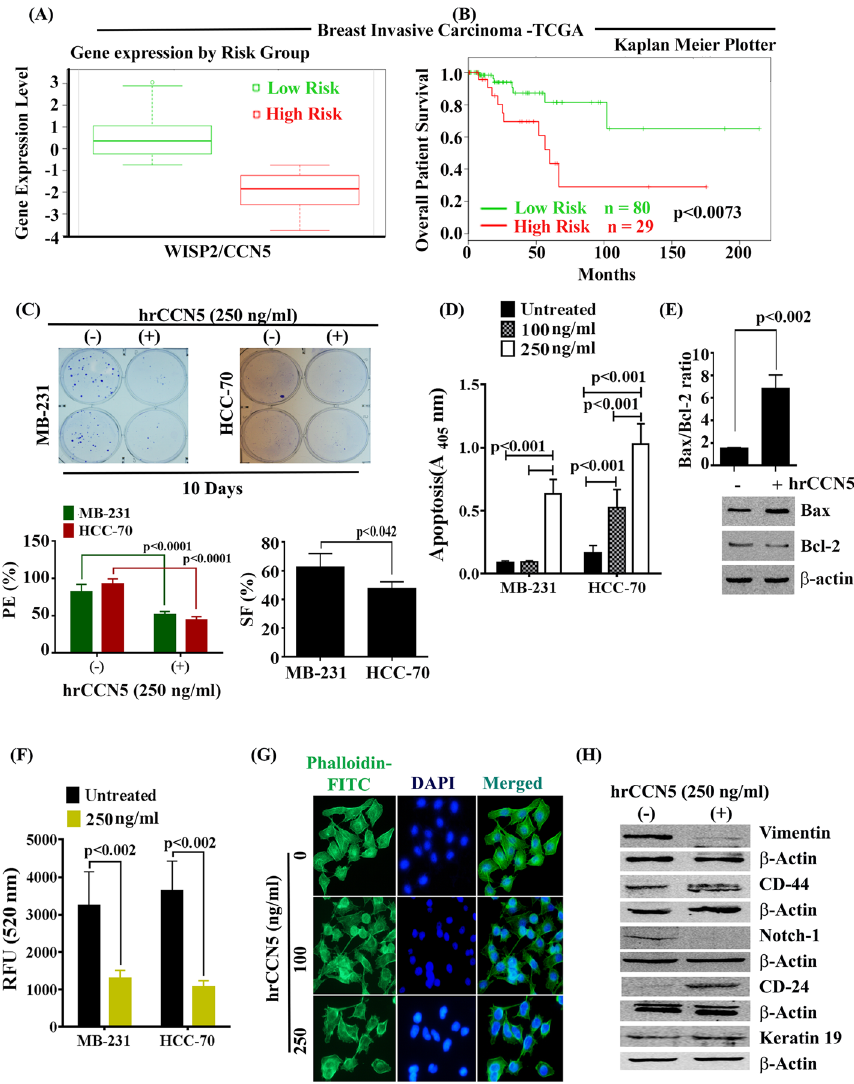
Figure 1. CCN5 overexpression is associated with good prognosis of human breast cancer and CCN5- treatment suppresses growth and invasive phenotypes of TNBC cells. ( A ) Plots generated by SurvExpress program to analyze samples of breast invasive carcinoma patients from TCGA show the expression levels of CCN5. Low- and high-risks groups are shown in green and red, respectively. ( B ) Kaplan-Meier overall survival curves of CCN5 signatures were constructed by using the SurvExpress program and the P-value resulting from a t-test of the difference. Low- and high-risks groups are shown in green and red, respectively. ( C ) Effect of hrCCN5 or vehicle alone (control) on cell survival of TNBC cells (i.e., MDA-MB-231 and HCC-70) was measured after 48 h using anchorage-dependent growth (ADG)/Colony/focus forming assay. We determined the plating efficiency (PE) (left panel) and survival fraction (SF) (right panel) in both cell lines as described in Materials and Methods. Upper panel is the representative images of ADG in different treatment setups. Bar graphs indicate PE (left) and SF (right) in hrCCN5-treated or control samples. Error bars indicate mean ± SD, and represent at least three independent experiments. ( D ) Dose-dependent effect of hrCCN5 on apoptotic cell death was measured in TNBC cells after 48 h using cell-death detection ELISA kits. Error bars indicate mean ± SD, and represent at least three independent experiments. ( E ) Representative Western blots and quantification (bargraph) of Bax/BCl-2 ratio in the lysates of hrCCN5-treated or vehicle-treated MDA-MB-231 cells. β -actin was used as loading controls. Error bars indicate mean ± SD, and represent at least three independent experiments. ( F ) Effect of hrCCN5 or vehicle alone on aggressive malignant phenotypes of TNBC cells was measured by anchorage-independent growth (AIG) using fluorescence-based soft agar colony forming assay. Error bars indicate mean ± SD, and represent at least three independent experiments. ( G ) Detection of morphological alteration from mesenchymal to epithelial type in MDA-MB-231 cells following hrCCN5 treatment using Phalloidin-FITC. ( H ) Representative Western blots of EMT markers in the lysates of hrCCN5- treated or vehicle-treated MDA-MB-231 cells. β -actin was used as loading controls. Statistical significance was determined using long rank test, two-way ANOVA and two-tailed unpaired Student’s t-test. All the photographs are cropped from original